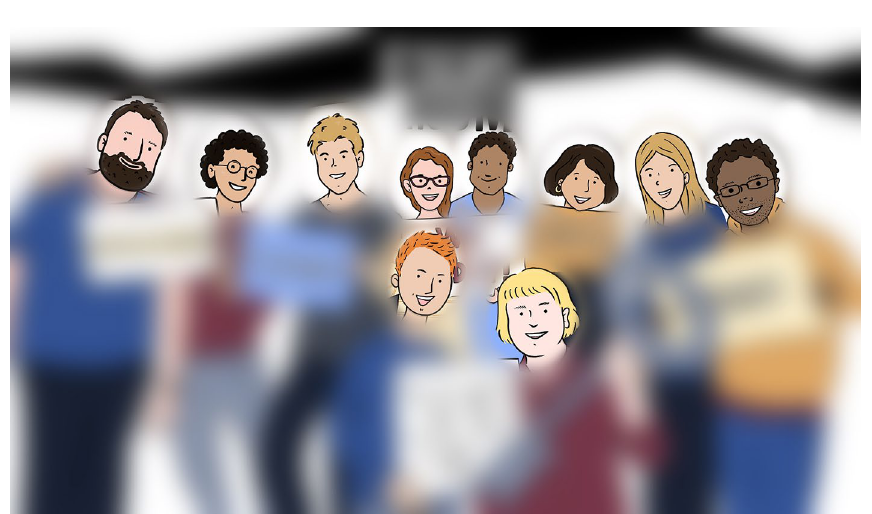
Figure 4. A sketch of a real photo shown to study participants asked to predict whether a group escaped or not (blurred version of the photo in Fig. 1). All performance-signaling information has been obfuscated, while still allowing participants to see the body posture and physical proximity of the group